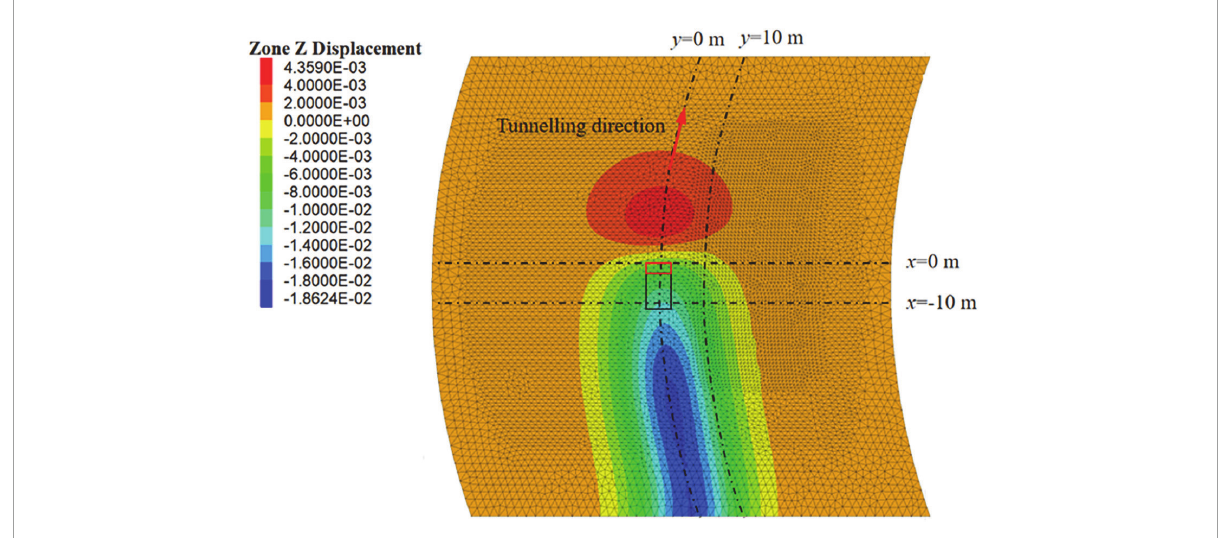
FIGURE6 Surface subsidence cloud